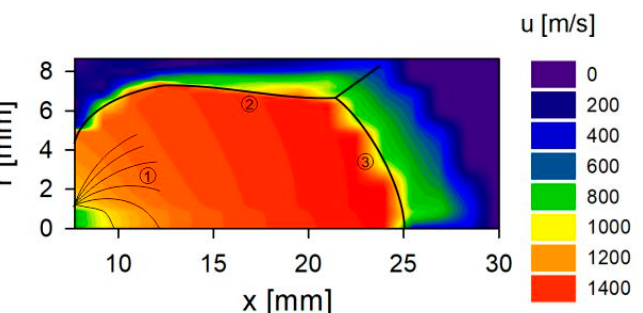
Figure 13. The velocity distribution at 20 µ s: 1: the Prandtl–Meyer flow, 2: the lateral shock, 3: the Mach disc.